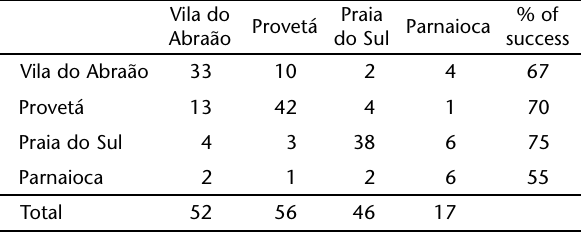
Table III. Discriminant analysis classification matrix of G. ticaga from four sites on Ilha Grande, Angra dos Reis, Rio de Janeiro, Brazil. Each column shows shell origin. Lines show shell identity: the number of shells correctly assigned to its proper population (in bold) and the number of shell that could be assigned to the other populations because of intrapopulation variation. Last column shows percentage success of shell